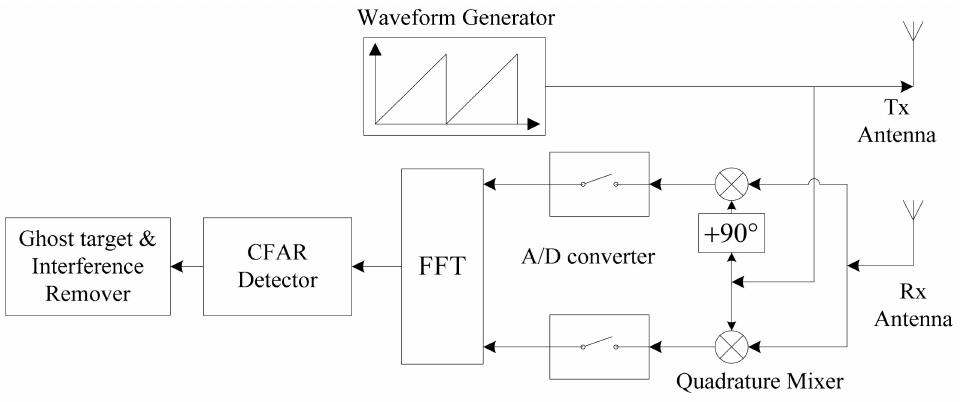
Figure 1. Block diagram of frequency modulated continuous wave (FMCW) radar system. FFT: fast Fourier transform; CFAR: constant false alarm